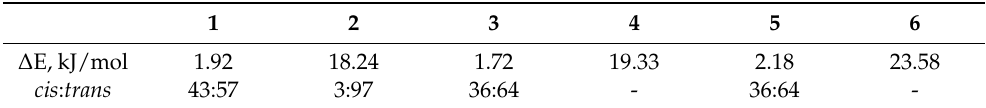
Table 2. Calculated energy differences between cis and trans isomers ( ∆ E, kJ/mol) and the cis:trans isomer ratio, based on the NMR data.